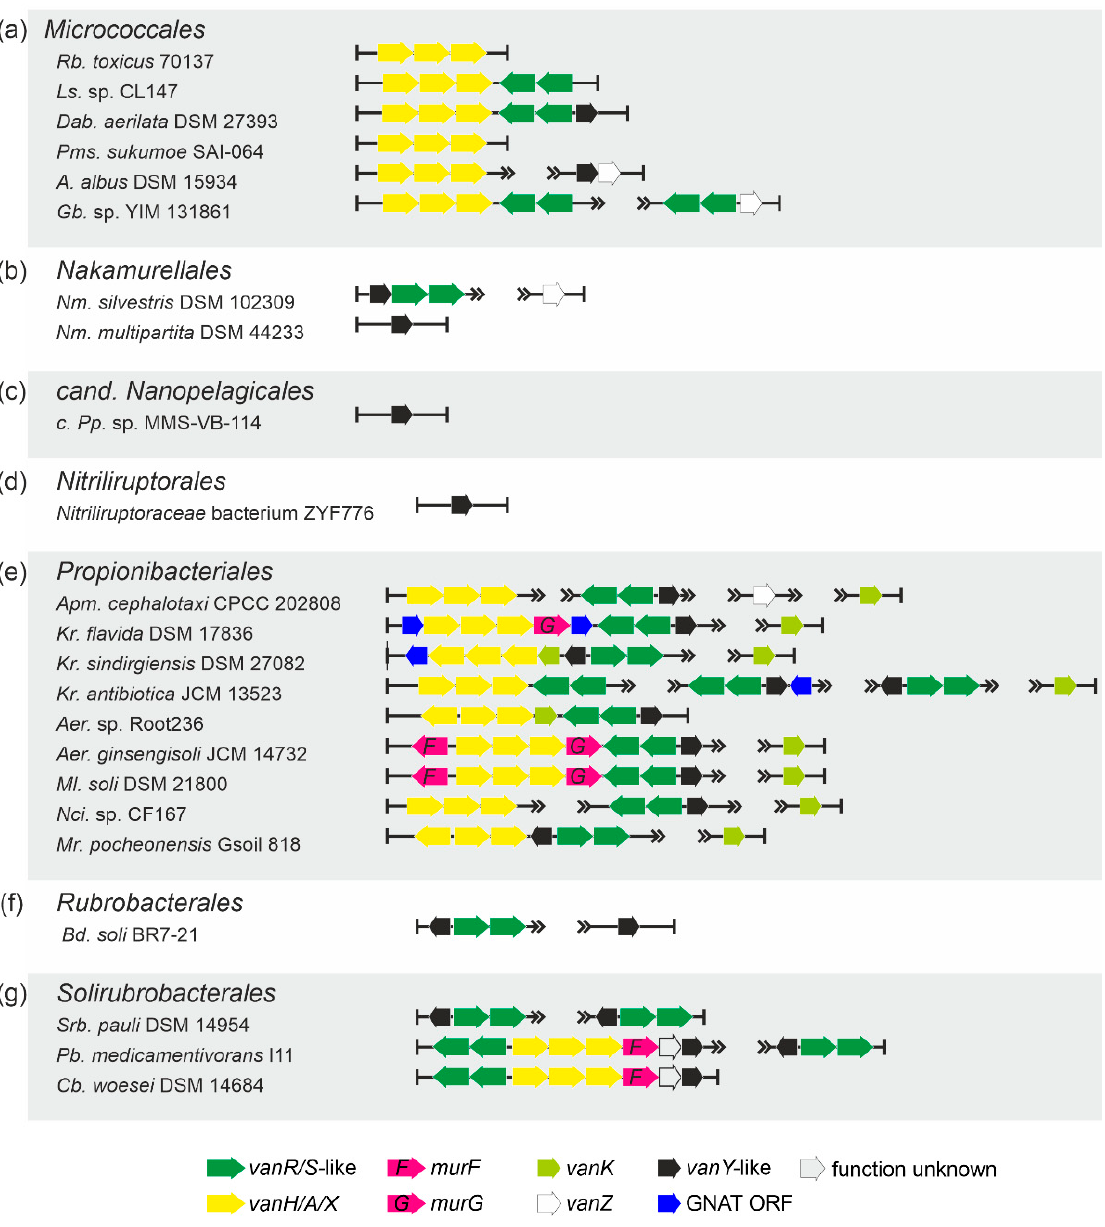
Figure 7. Arrangements of vlgs discovered in representative genomes from the orders ( a ) Micrococcales , ( b ) Nakamurellales , ( c ) candidatus Nanopelagicales, ( d ) Nitriliruptorales , ( e ) Propionibacteriales , ( f ) Rubrobacterales and ( g ) Solirubrobacterales . Please refer to the main text for more details; genus names were abbreviated according to the ESM Table S1. The legend below the figure explains the color-coding of the scheme.